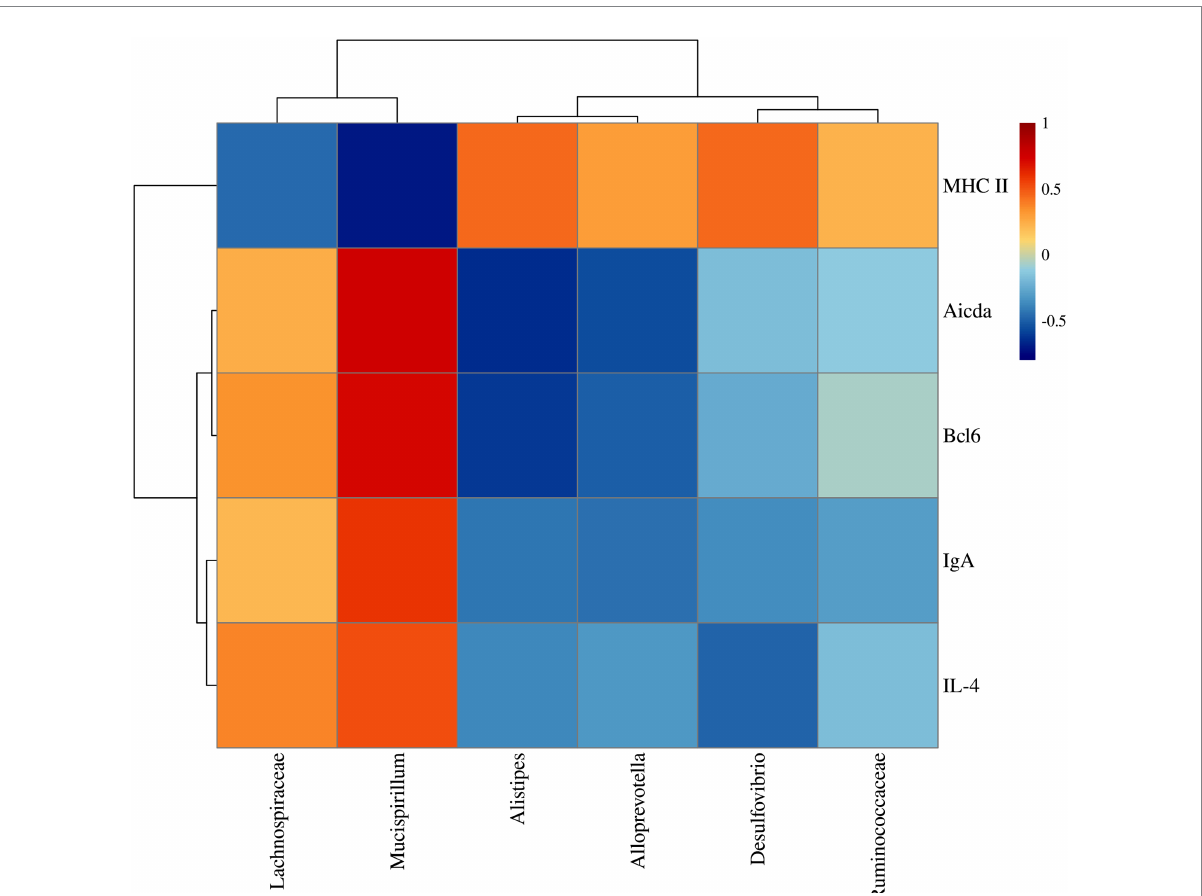
FIGURE 10 Correlation analysis between TD IgA related indexes and colonic mucosal flora of UC mice after YJP-A